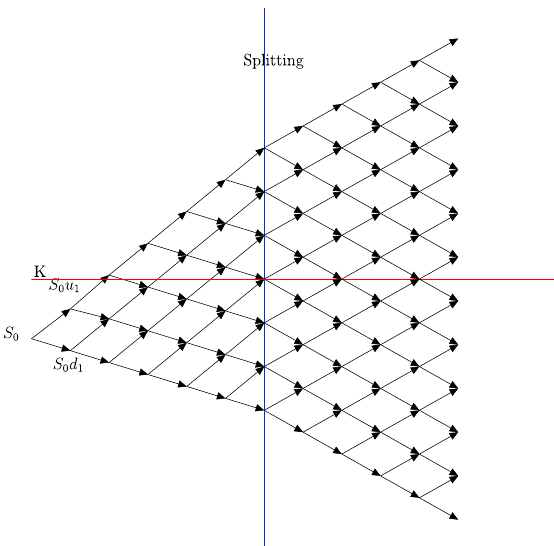
Figure 1. Values of the split tree in the log-space for Joshi’s original split tree. Here n = 11, and from time step k = ceil ( n /2 ) onward, the tree is centered around the strike K